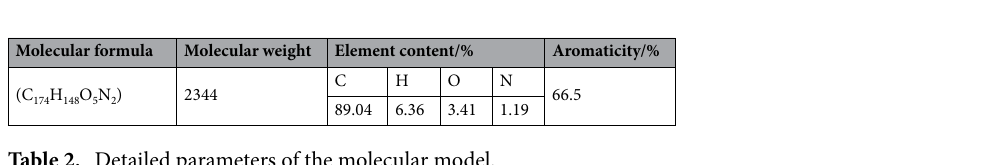
Table 2. Detailed parameters of the molecular